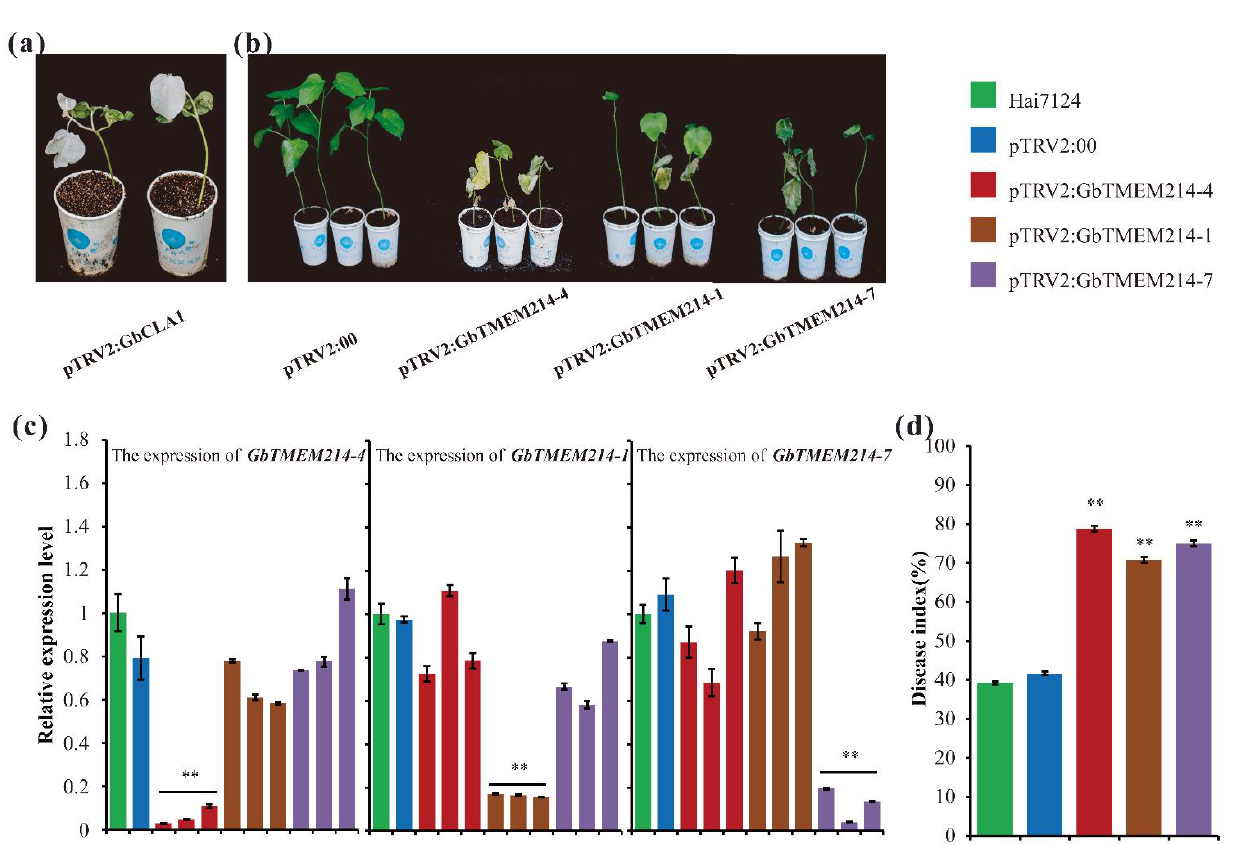
Figure 7. The resistance function analysis of the GbTMEM214 genes using VIGS. ( a ) The cotton gene GhCLA1 was used as a positive control, and VIGS of GhCLA1 results in a phenotype of white leaves; ( b ) The phenotypes of Hai7124 under infection with V. dahliae after VIGS with Agrobacterium carrying pTRV2:GbTMEM214s and pTRV2:00 , and the photos were taken at 42 days after V. dahliae inoculation; ( c ) qRT-PCR analysis of the expression levels of GbTMEM214s in the silenced lines; ( d ) The disease index of plants with silenced GbTMEM214s . The data for each cotton line were filled in different colors. The qRT-PCR data were expressed relative to Hai7124 for each gene. The results were evaluated at 28 d after V. dahliae inoculation, with three replications containing at least 20 plants each. “**” represent significant differences relative to each control and p -value < 0.01, based on Student’s t -test. Each value was the mean ± SD of three biological determinations.